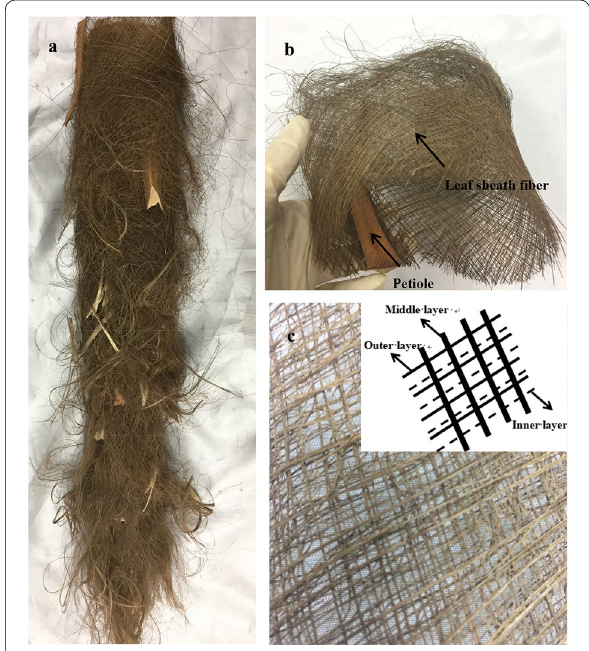
Fig. 1 Photograph of a windmill palm tree covered with leaf sheath; b leaf sheath; c a small piece of leaf sheath showing the arrangements of different layers of fiber bundle, with inserted images showing the schematic view of fiber